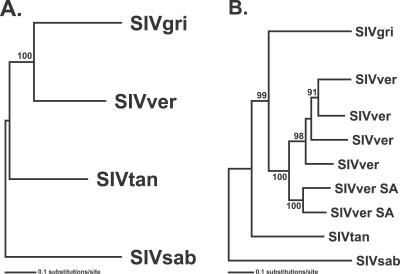
Phylogenetic Relationships among SIVagm Genomes(A) SIVagm genomes and (B) SIVagm genomes plus two SIVver env genes from South Africa (SA). Both trees are shown with SIVsab as an outgroup, although midpoint rooting produces the same rooting pattern. ML nonparametric bootstrap support values (>50%) are shown on nodes.